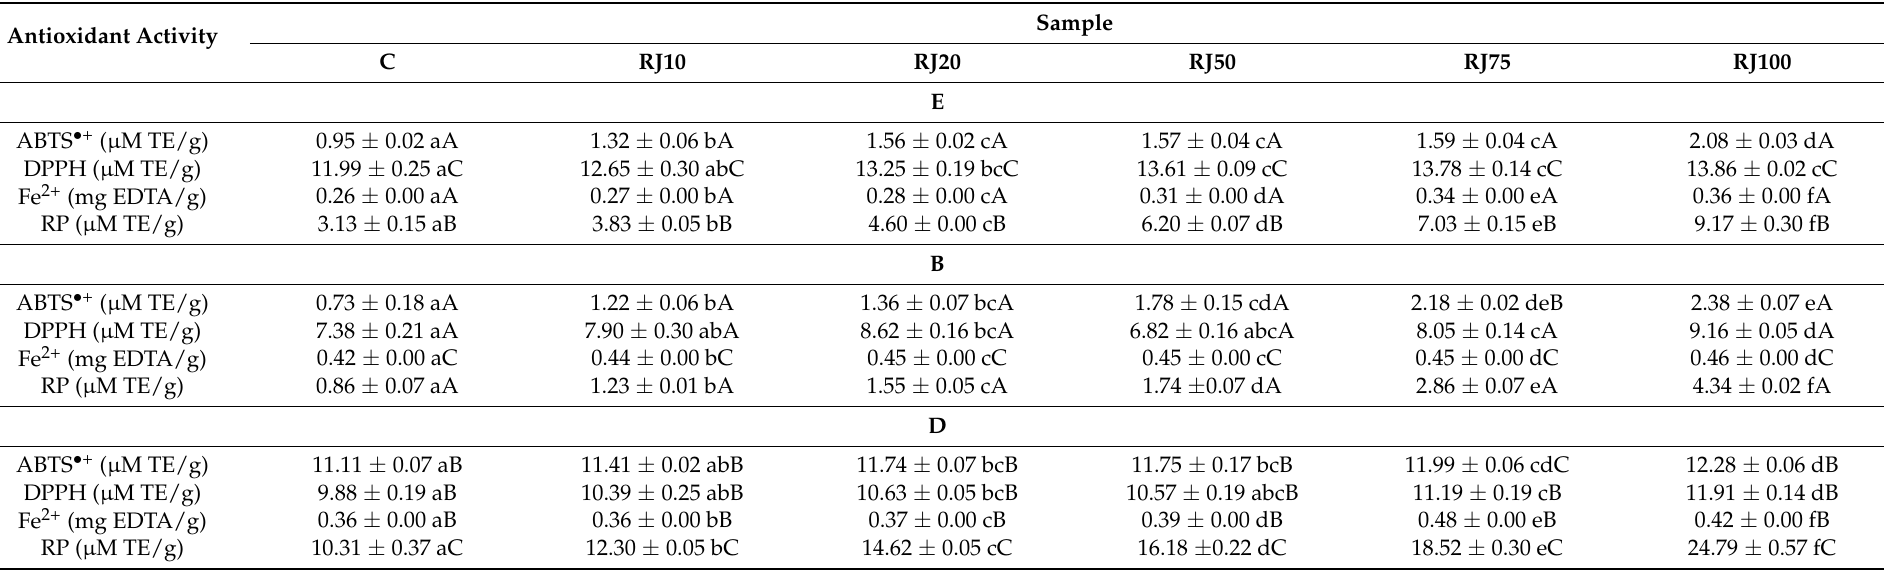
Table 4. Antioxidant properties of the control and fortified